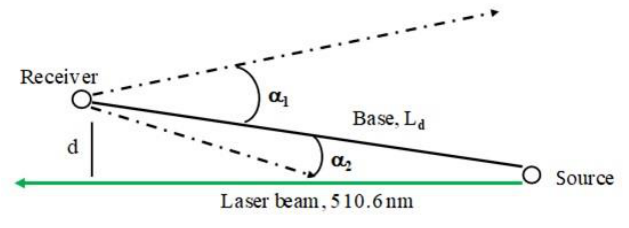
Figure 10. Geometric scheme of experiments (2019) in water under the ice surface described by Figure 9a.